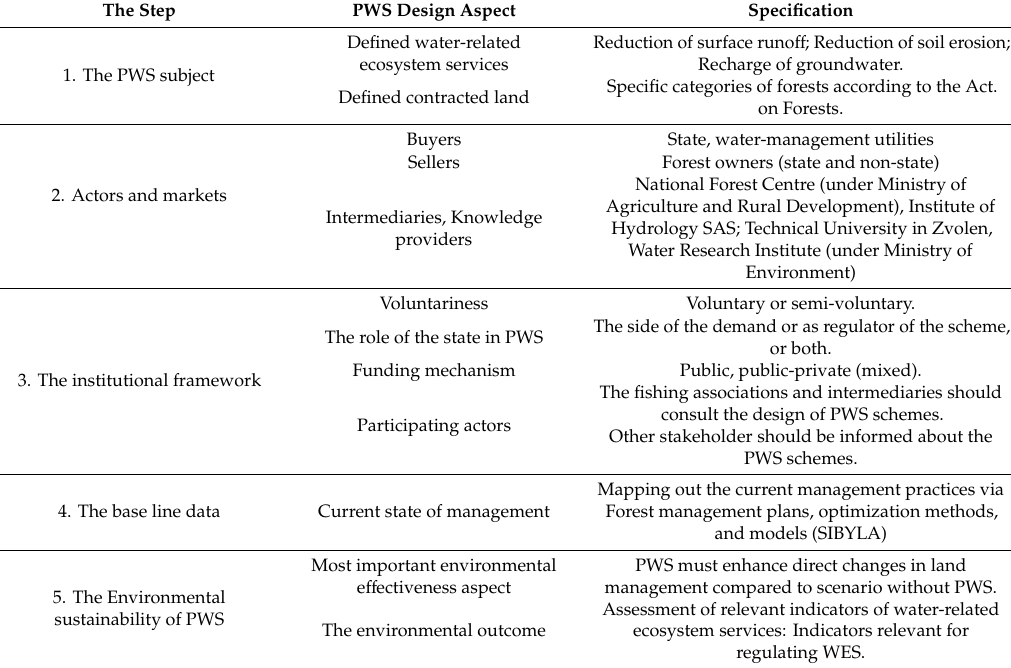
Table 8. The main features of PWS schemes future development in